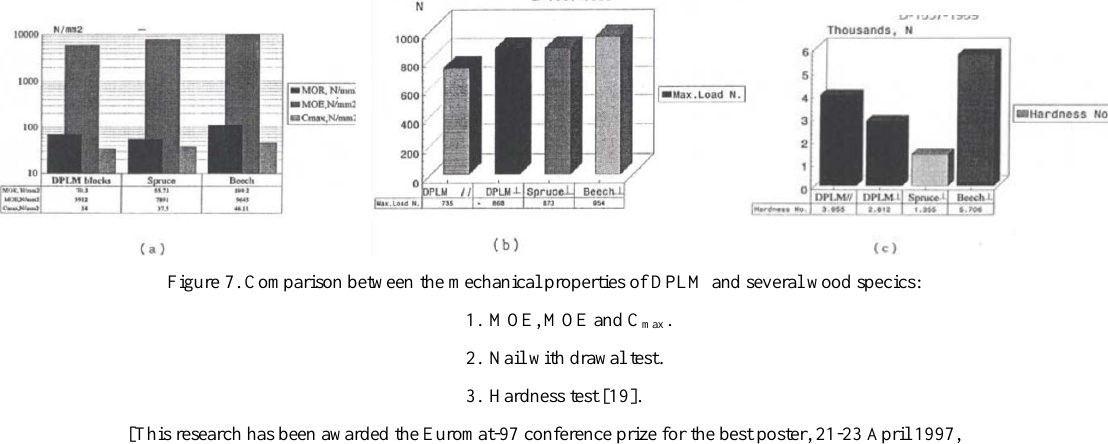
Figure 7. Comparison between the mechanical properties of DPLM and several wood specics: 1. MOE, MOE and C max . 2. Nail with drawal test. 3. Hardness test [19].